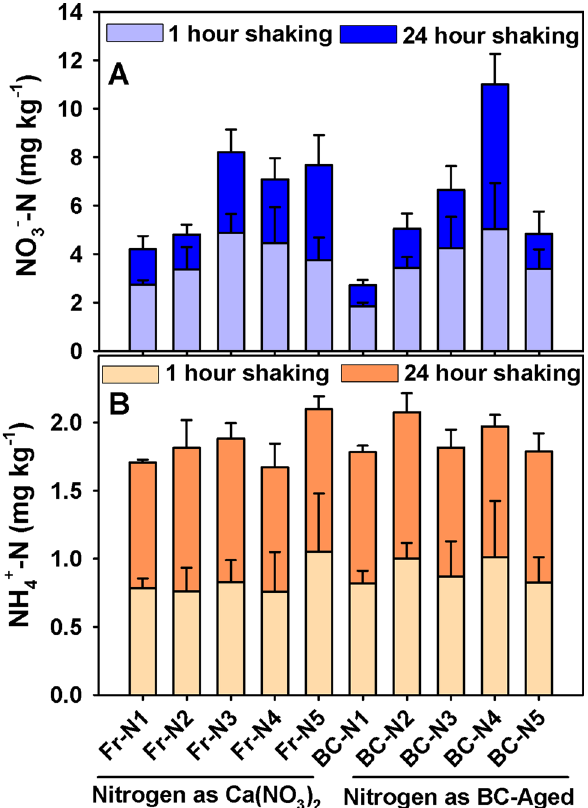
Figure 3. Effect of different nitrogen sources as [(CaNO 3 ) 2 and N captured in BC-aged] and levels of application (N-1 = 0, N-2 = 44, N-3 = 88, N-4 = 176 and N-5 = 352 kg ha −1 ) on leftover mineral N in potted soil after the harvest of quinoa under controlled conditions (means + s.d., n = 4). The mineral contents presented in the stacked bars are the sums of 1 + 24-h extractions (base and top respectively). Note that the y-axis scales of ( A ) (NO 3 − ) and ( B ) (NH 4 + ) are different, based on the respective N concentration in potted soil. There was no significant difference among N sources or levels following two-way ANOVA ( P ≤